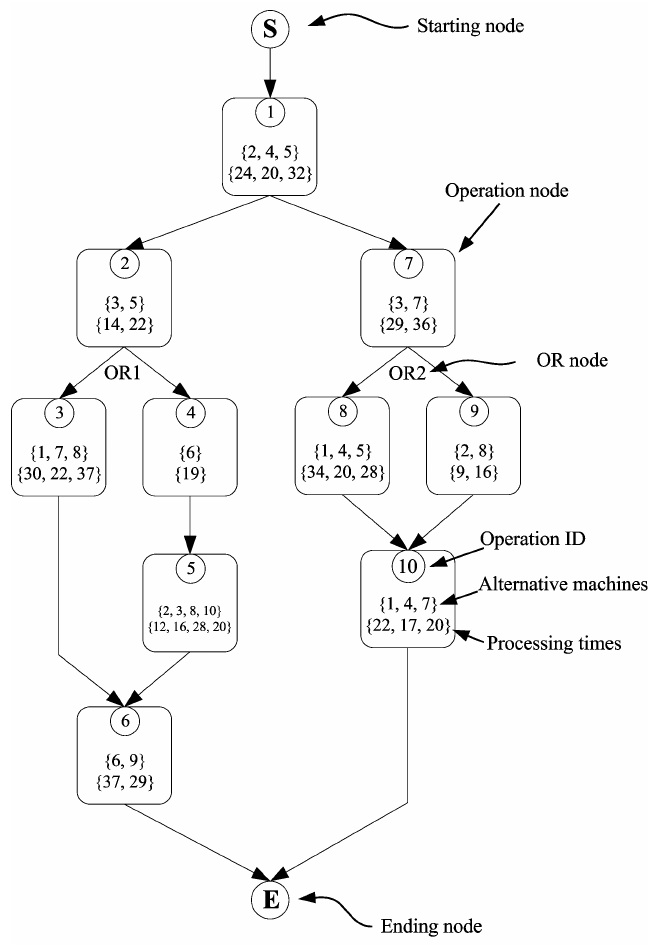
Figure 1. The network graph of a